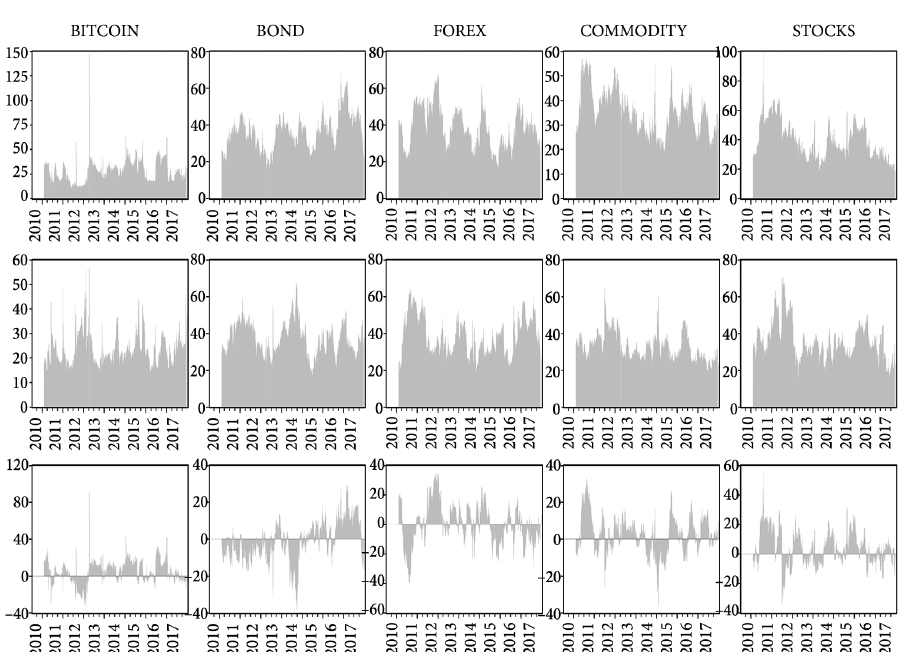
Figure 7. Upper panel: Directional volatility spillovers, direction TO, from good volatility, middle panel: directional spillovers, direction TO, from bad volatility, lower panel: the directional spillover asymmetry measures 2 , H N i